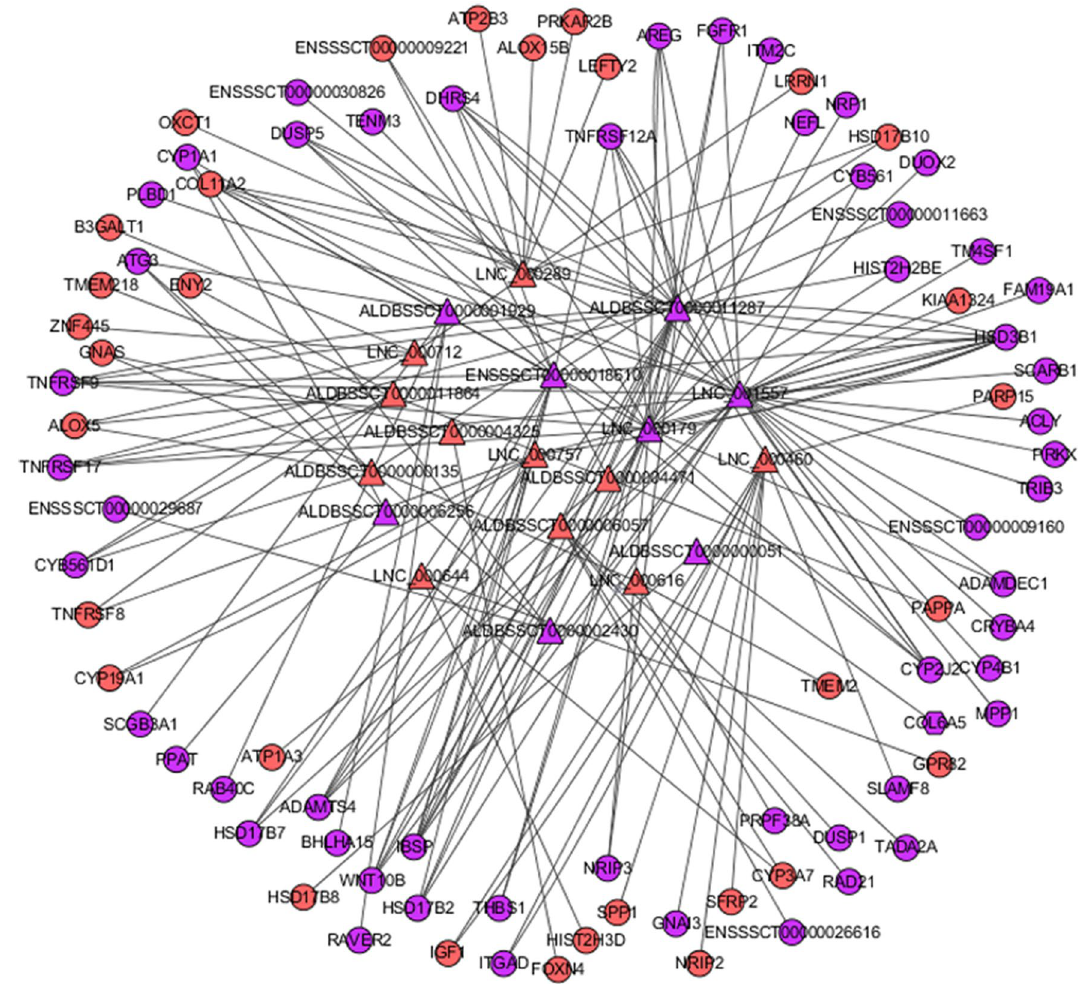
Figure 6. The interaction analysis of PTGs and DELs in estrogen metabolic process and ovarian steroidogenesis signaling pathway. Triangles represent lncRNAs, circles represent mRNA, and red is up-regulated genes, purple is down-regulated genes.